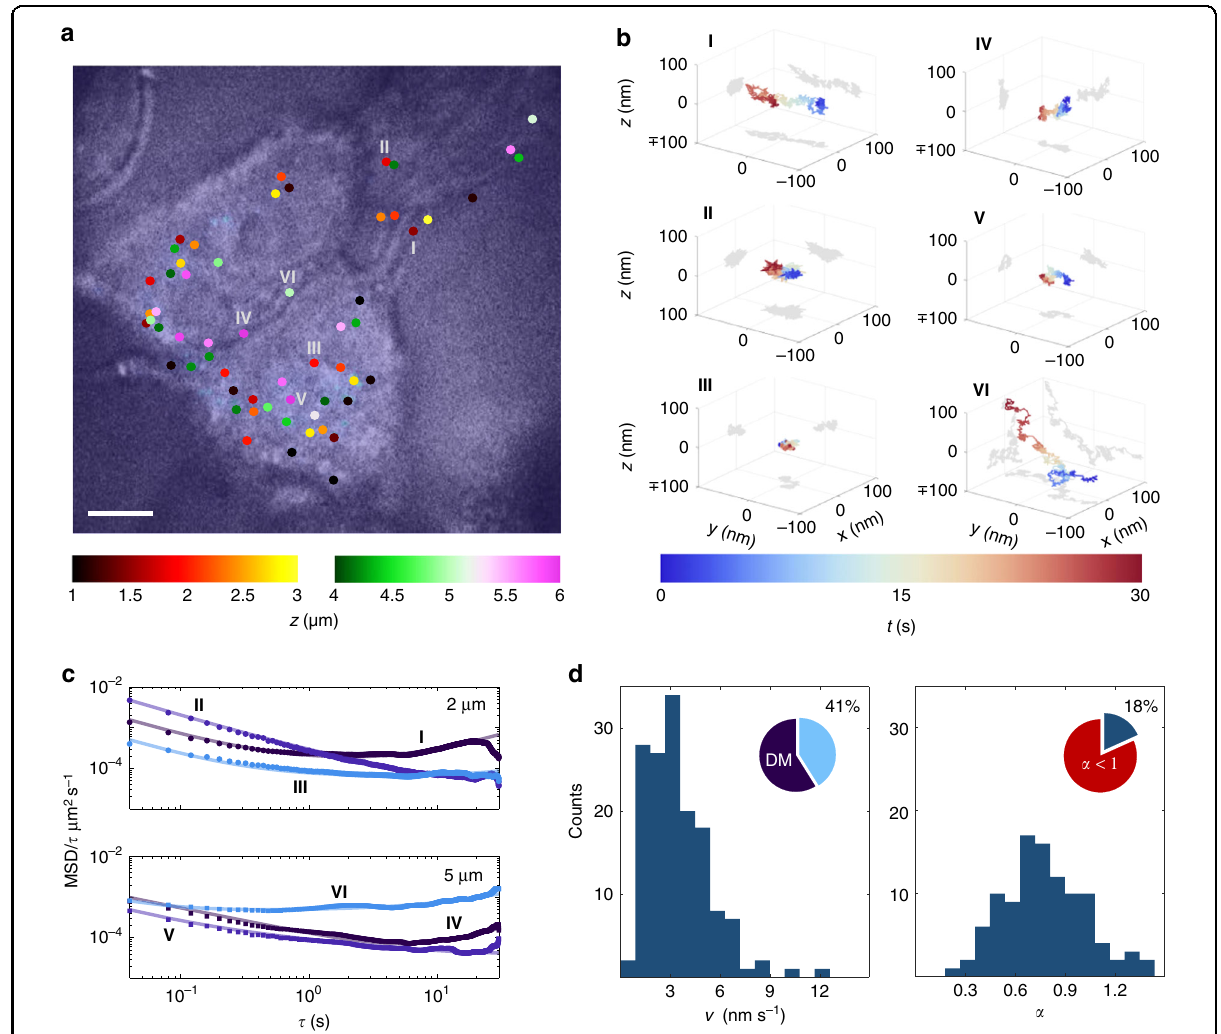
Fig. 3 3D-SPT in human lung carcinoma (A549) cells by TEMPSI. a Overlay of white light and fl uorescence images of representative A549 cells with embedded beads. Six beads whose tracks are shown in ( b ) are numbered in Roman numerals. Color re fl ects imaging depths of ~2- μ m and ~5- μ m relative to the glass-cell interface (hot and green-pink colormaps, respectively). The beads at each depth were tracked simultaneously over 30 s at 25 3D localizations s − 1 with an average of ~35 × 10 3 photons/localization. Scale bar, 5 μ m. b 3D trajectories of the six beads numbered in Roman numerals in ( a ), where the trajectory color encodes time going from blue to red. c log – log MSD/ τ curves of the trajectories in ( b ). The vertical axis shows the ratio of the mean square displacement to the lag time. Dots and squares are measurements and solid lines are fi ts. The curved convex lines (I and IV), the negative slope lines (II and V), and the slow slope curves straightened at longer lag times (III and VI) are characteristic of directed, subdiffusive, and diffusive motions in the cell microenvironment, respectively. d Histograms of the speed ( v , left; n = 149 trajectories) and the exponent α (right; n = 104 trajectories) of the motion in the cell microenvironment. 59% of the trajectories showed directed motion (DM), whereas from the remaining 41% trajectories, 82% exhibited α <